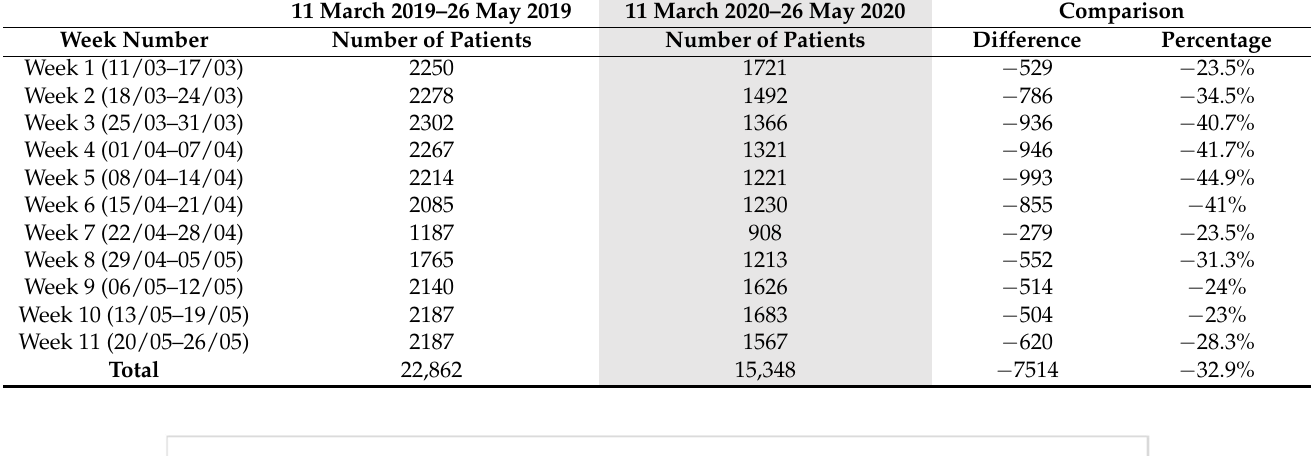
Table 3. Number of patients who underwent diagnostic examinations per week during the ordinary activity (11 March 2019–26 May 2019) and during the COVID-19 pandemic emergency (11 March 2020–26 May 2020) by the radiology department of our institution; the comparisons between the two-time intervals are expressed both in absolute values and in percentages.